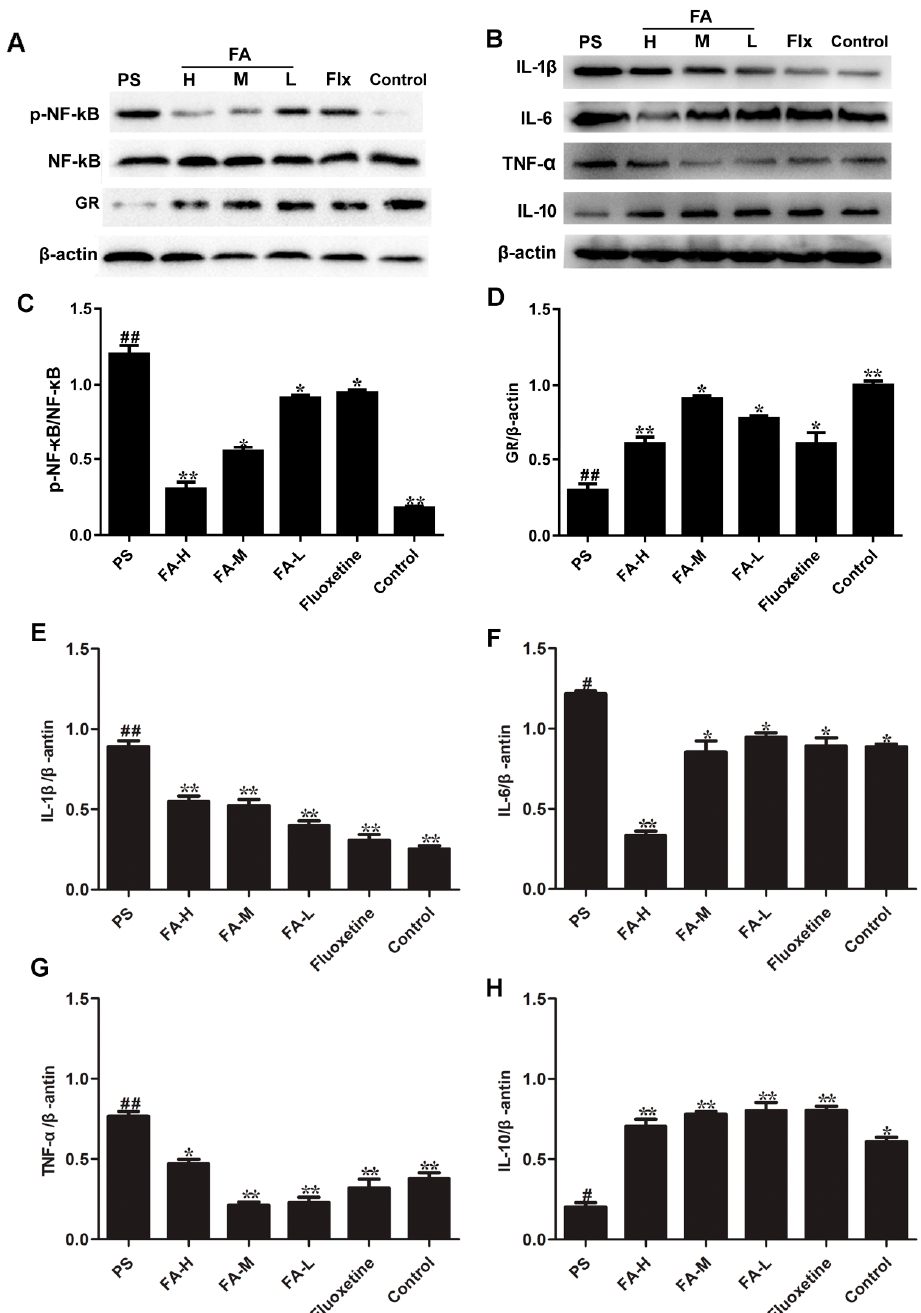
Figure 9. Effects of ferulic acid (FA) on the NF- κ B activation, GR and IL family members expression in the hippocampus of offspring rats exposed to prenatal stress. ( A ) Bands of p-NF- κ B/NF- κ B and GR in the hippocampus. ( B ) Bands of IL family in the hippocampus. ( C ) Bands of p-NF- κ B were quantified based on densitometric analysis and then normalization to NF- κ B. ( D ) Bands of GR were quantified based on densitometric analysis and then normalization to β -actin protein levels. Bands of ( E ) IL-1 β , ( F ) IL-6, ( G ) TNF- α and ( H ) IL-10 were quantified based on densitometric analysis and then normalization to β -actin protein levels. Values represent means ± SEM ( n = 3). * p < 0.05 and ** p < 0.01 compared with PS group, # p < 0.01 and ## p < 0.01 compared with Control group. FA-L: FA at low 12.5 mg/kg/day, FA-M: FA at medium 25 mg/kg/day, FA-H: FA at high 50